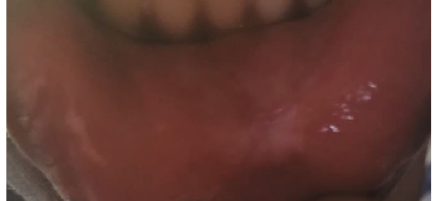
Figure 10: Healed donor site.